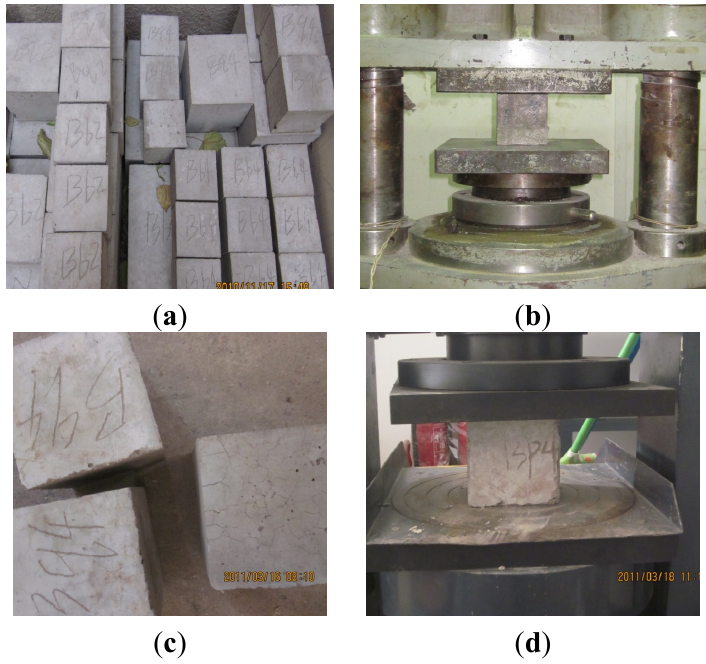
Figure 5. The cubic compressive strength test before and after fire: ( a ) the cubic concrete specimens before fire; ( b ) testing before fire; ( c ) the cubic concrete specimens after fire; and ( d ) testing after fire.